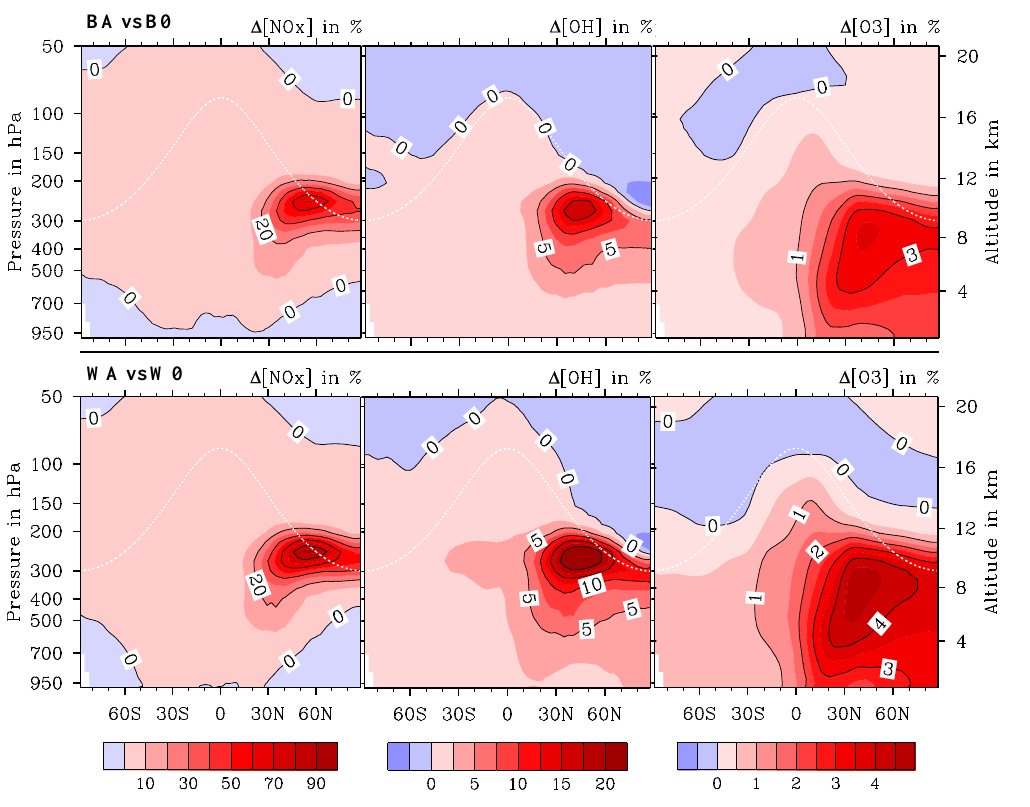
and 100 · WA − W0 B0 W0